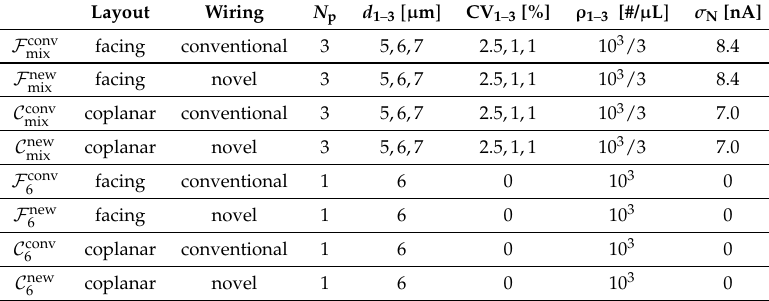
Table A1. Parameter values used in the generation of the synthetic data streams (for all data